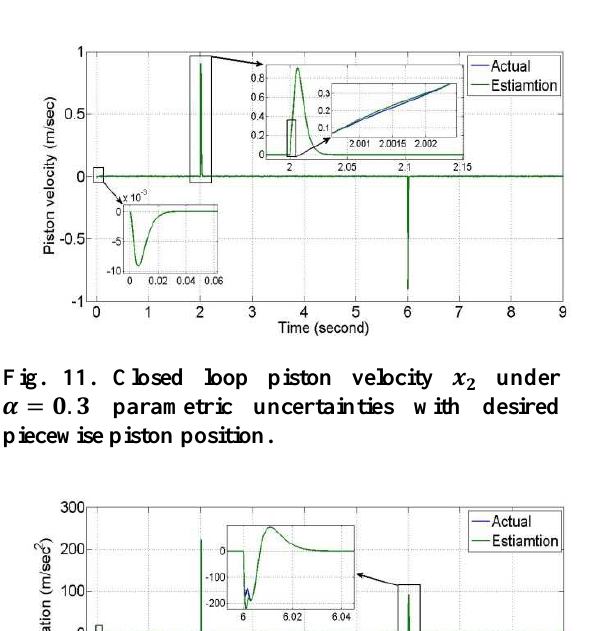
Fig. 12. Closed loop piston acceleration under parametric uncertainties with desired piecewise piston position.